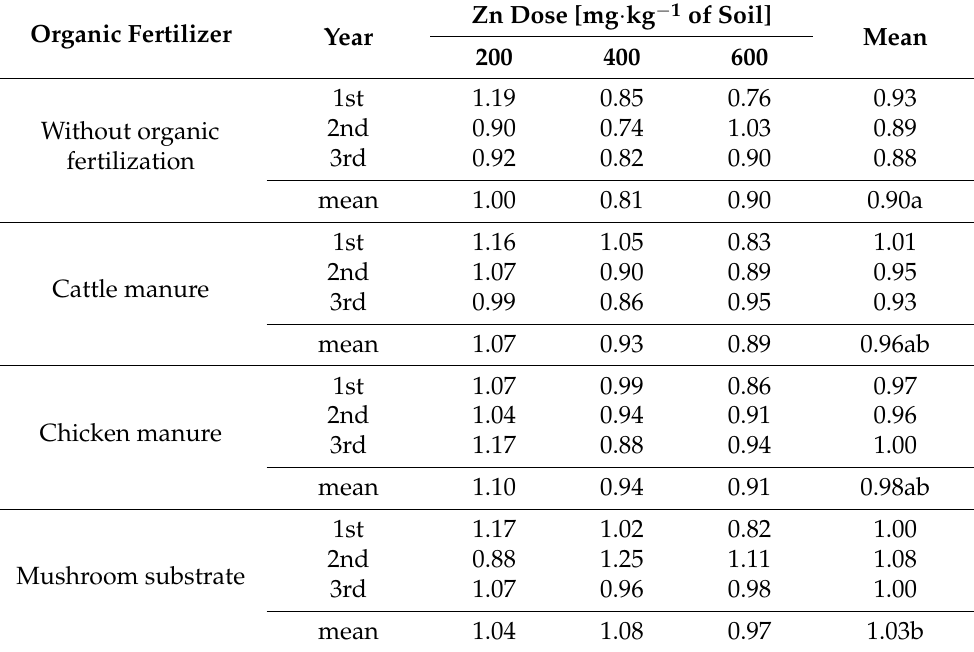
Table 3. Zinc tolerance index illustrating the effect of increasing levels of zinc in combi-nation with application of various organic